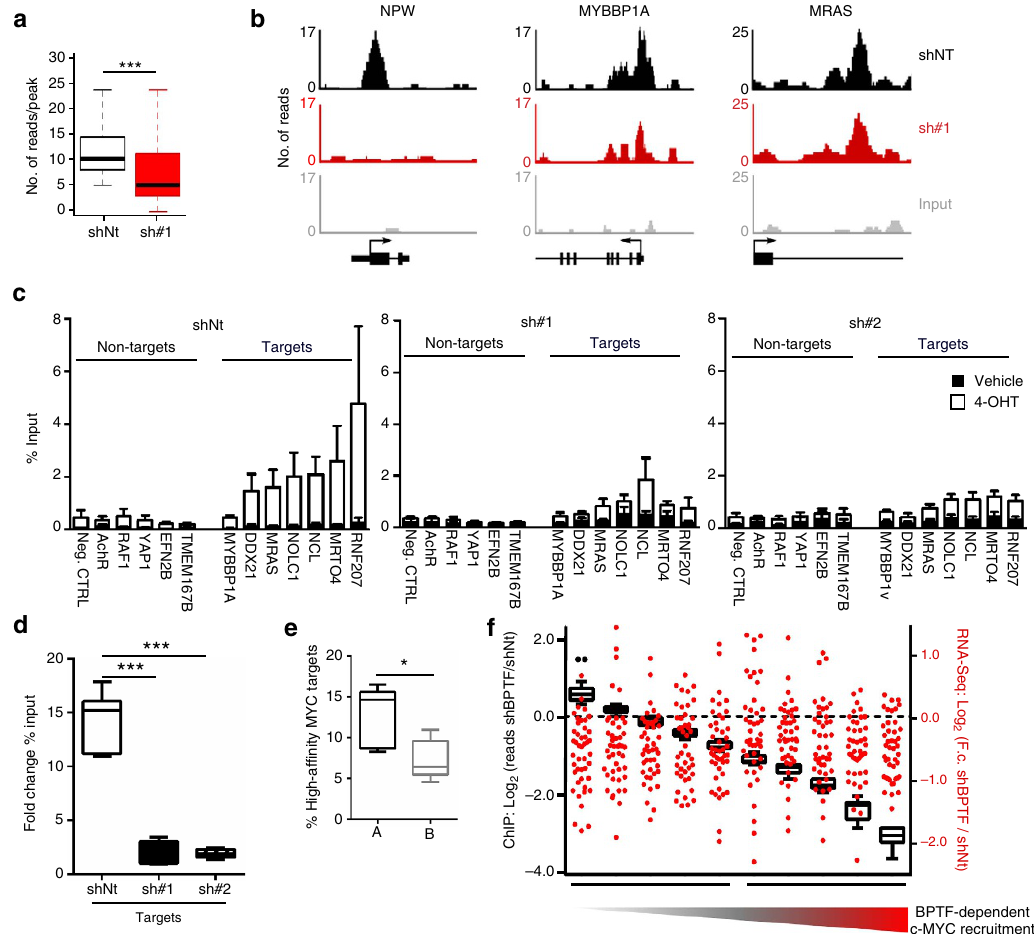
Figure 2 | BPTF silencing interferes with c-MYC recruitment to its target genes. ( a ) Box plot showing the intensity of c-MYC ChIP-Seq signal (reads per peak) at MYC-enriched regions in control and BPTF-silenced HFF MYC-ER cells. MYC-enriched regions were defined in 4-OHT-treated control cells. c-MYC-binding intensity was measured as number of reads per peak. *** P o 0.001 (Wilcoxon test). ( b ) Representative snapshots of c-MYC-bound genomic regions in control and BPTF-silenced HFF MYC-ER cells after stimulation with 4-OHT. ( c ) ChIP analysis of c-MYC enrichment at the promoters of ‘target’ and ‘non-target’ genes in control and BPTF-silenced HFF MYC-ER cells in the presence (white) or absence of 4-OHT (black). ChIP values are expressed as average ± s.e.m. of % input chromatin. An isotype-matched IgG antibody was used as control (Supplementary Fig. 3f) and Z 3 independent experiments were analysed per promoter region. ( d ) Fold change in % of input following 4-OHT addition, averaged for the two different promoter populations in control and BPTF-silenced cells. *** P o 0.001 (unpaired t -test). ( e ) Groups A and B are defined as in f . High-affinity MYC targets are significantly enriched among